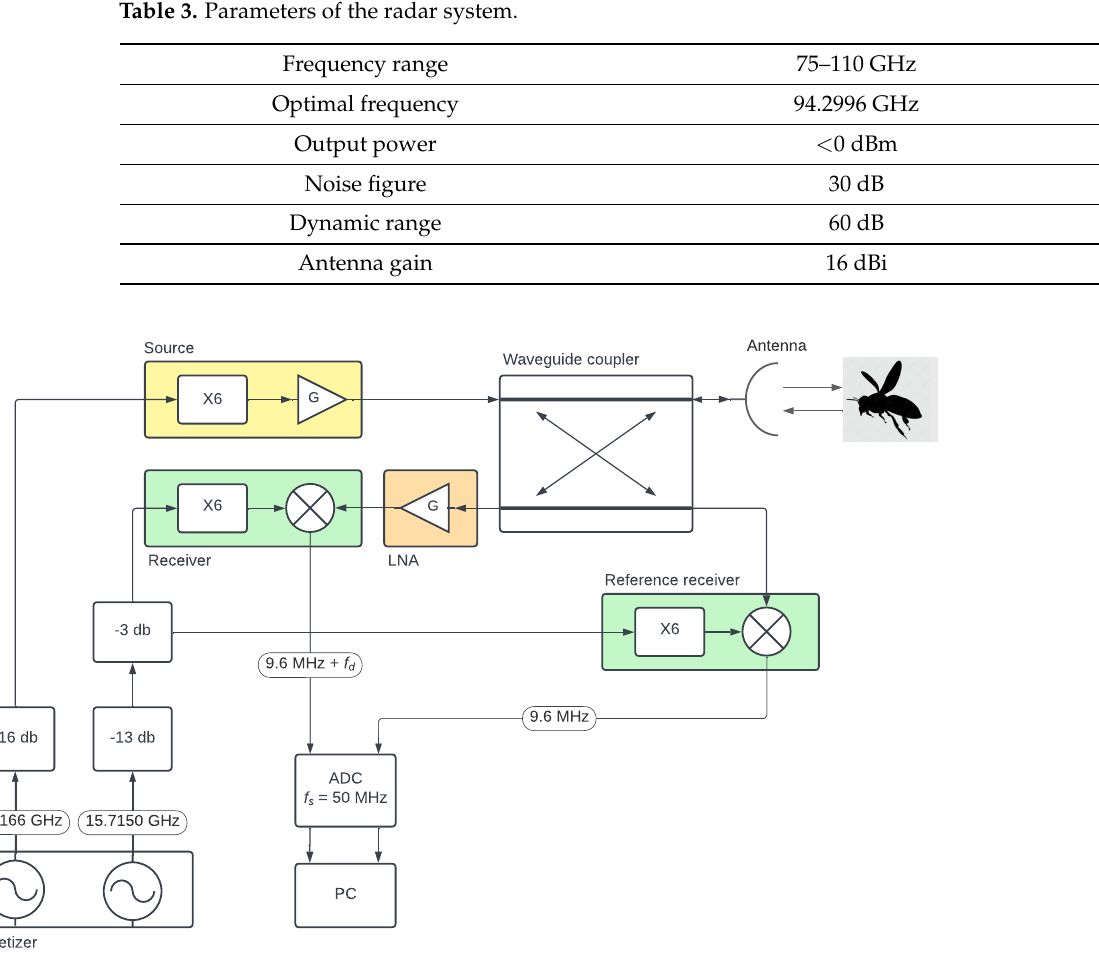
Figure 2. Radar system used in the experimental